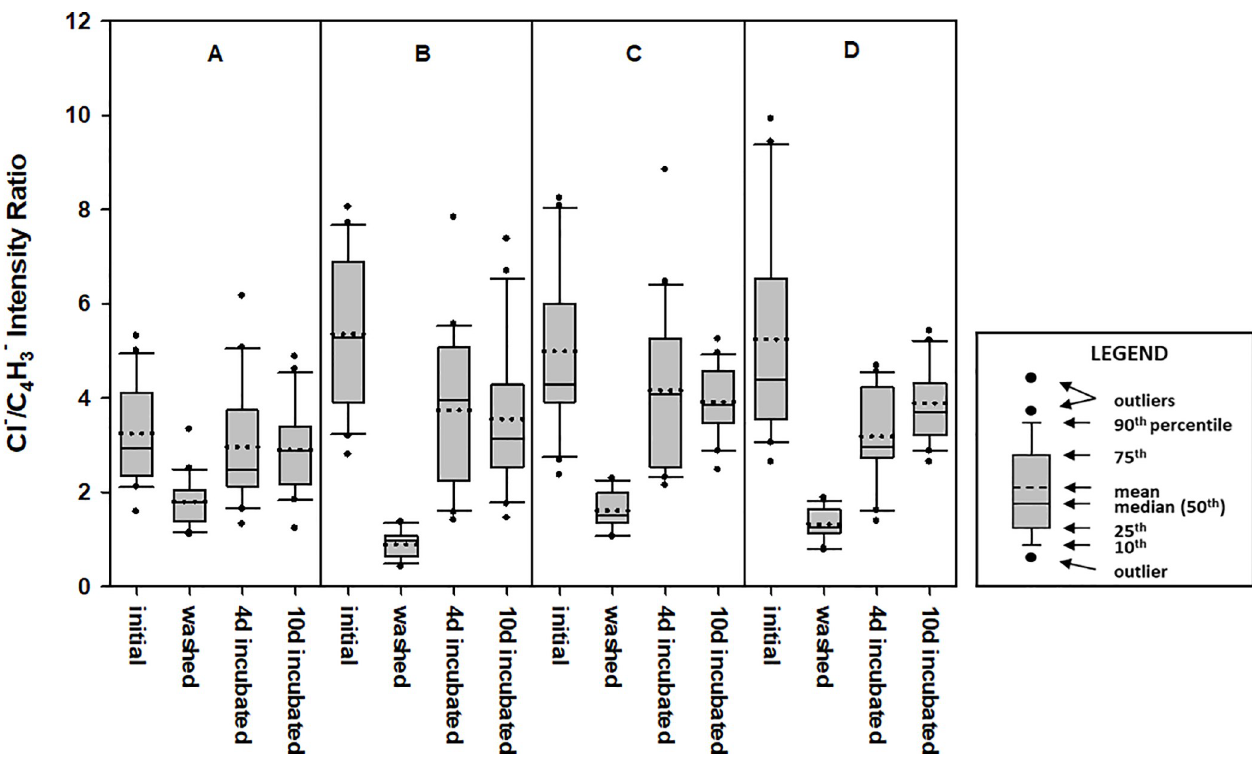
Fig 5. Box plots showing the regeneration of 35 Cl - at the surface of Olyset fibers from four specimens (A through D) after washing with acetone and subsequent incubation for 4 and 10 days at 30˚C. Initial readings were carried out after samples were pressed and sputtered. Analysis area of each location is 500 μ m × 500 μ